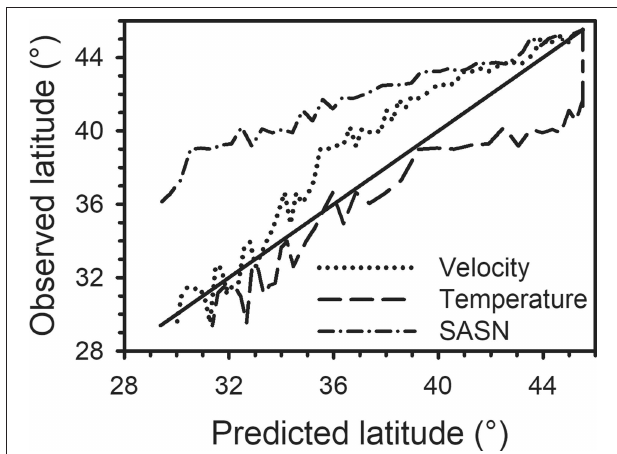
FIGURE 5 | For each day-of-year between 229 and 296, mean location ( ◦ latitude) was calculated for each of three movement scenarios (constant SASN, Velocity, Temperature) (Predicted latitude) and graphed against observed mean tagging latitude on that day-of-year (Observed latitude). Solid line represents when predicted mean latitude and observed mean latitude were equal. On a given day-of-year, results above the solid line indicate that the predicted mean latitude was lower (i.e., further south) than observed and results below the solid line indicate the predicted latitude was greater (i.e., further north) than observed. Predicted mean latitude was based on a 2,947-km migration from 49.34 ◦ N to 22.82 ◦ N latitude along longitude 100.3 ◦ W.